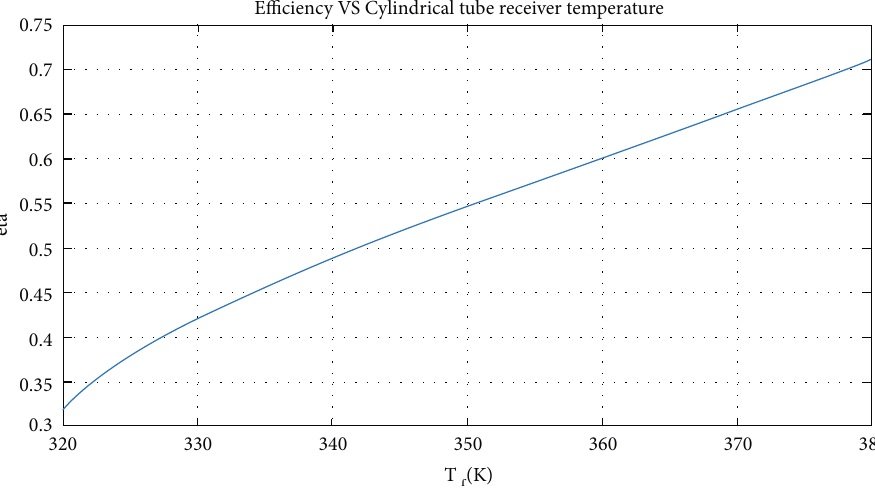
Figure 4: Changes in the e ffi ciency of the absorber pipe by the temperature of its